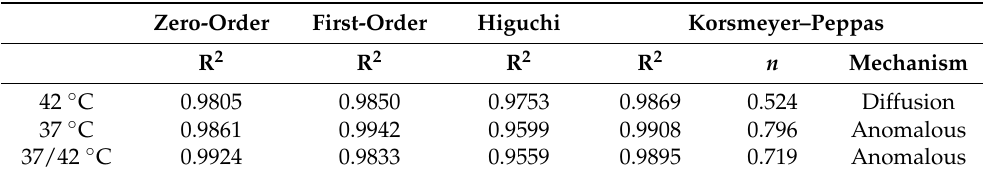
Table 9. The fitting of the mathematical models to drug release profiles from hydrogels in simulated hyperthermia